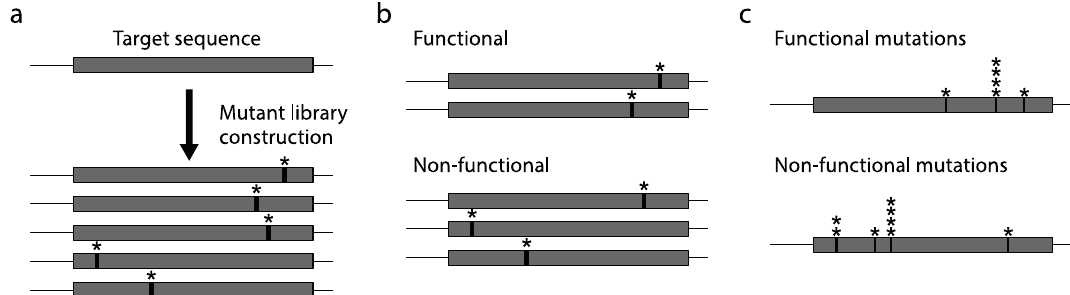
Figure 1. Schematics of the simplified overview of deep mutational scanning: ( a ) generation of the initial protein variant library for target protein sequences; ( b ) screening for protein variants with desired properties; and ( c ) sequencing and quantification of the mutations under different selection pressures. The asterisks indicate mutations at a specific site and the stacked asterisks indicate enrichment of mutations in specific sites after quantification. For example, mutation counts at different sites are shown with * positions carrying a mutation, ** positions carrying two mutations, and **** positions carrying four